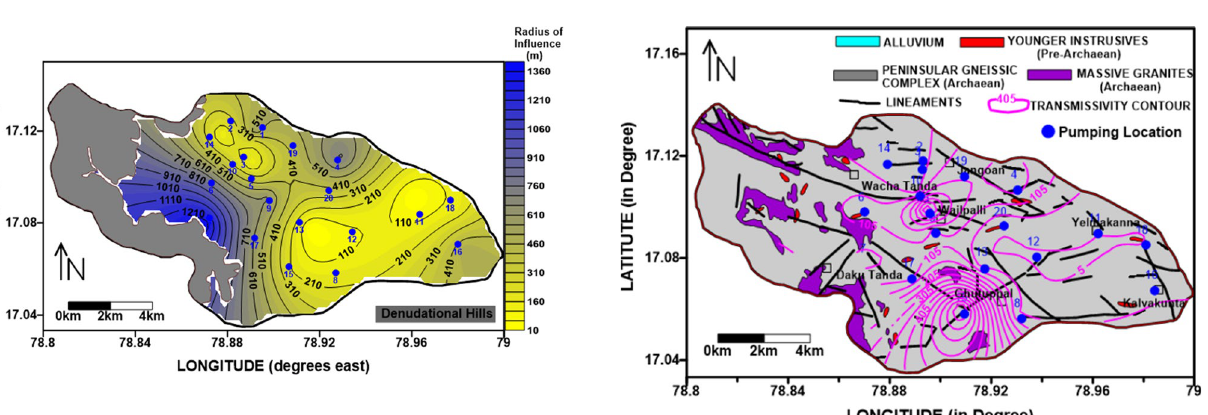
Fig. 7 Map showing the contour pattern of radius of influence (meters) of each pumping test well